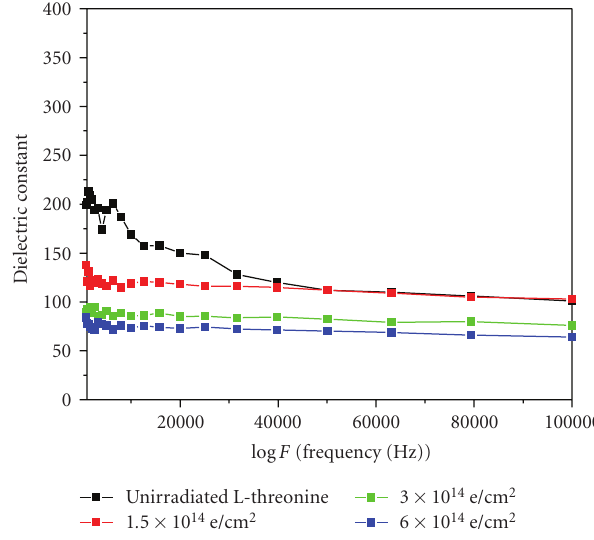
Figure 51: Dielectric constant of L-threonine for various electron